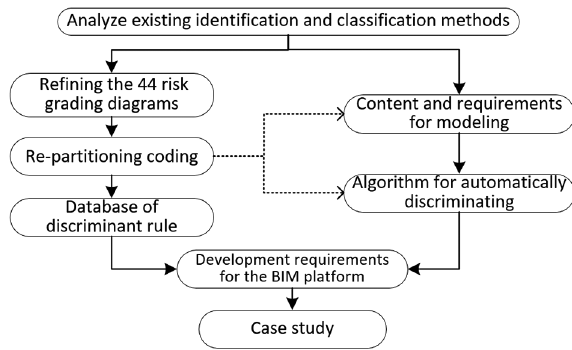
Figure 1. Research